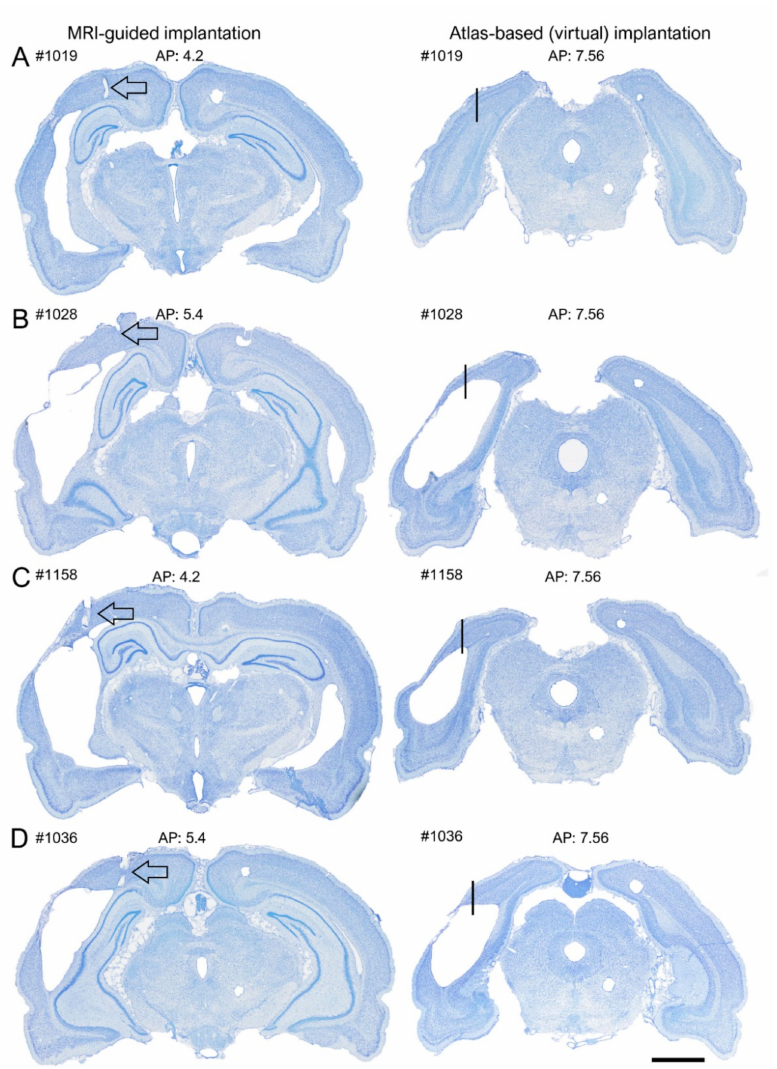
Figure 10. Location of electrode tip at 5 months postinjury without prior MRI analysis. Photomi- crographs of thionine-stained coronal brain sections of 4 animals; ( A ) #1019, ( B ) #1139, ( C ) #1158 and ( D ) #1036 in the MRI cohort with electrode implantations at 5 months after TBI. Left panels: MRI-guided placement of the posterior cortical electrode. Note that all electrodes are within the perilesional cortex. Right panels: The location of the electrode tip (arrow), if the electrode was implanted according to the targeted atlas-based coordinates ( − 7.56 mm from bregma, 4 mm from midline, 1.8 mm from the surface of the brain). Note that in all rats except 1019, the electrode tip ended in the lesion cavity. Table 2 summarizes the locations for all cases. Scale bar = 2